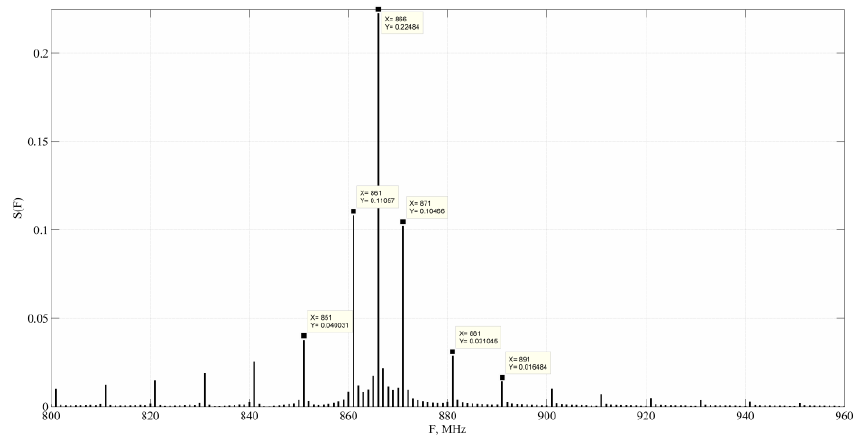
Fig. 4. Spectrum of the test sequence with ASK